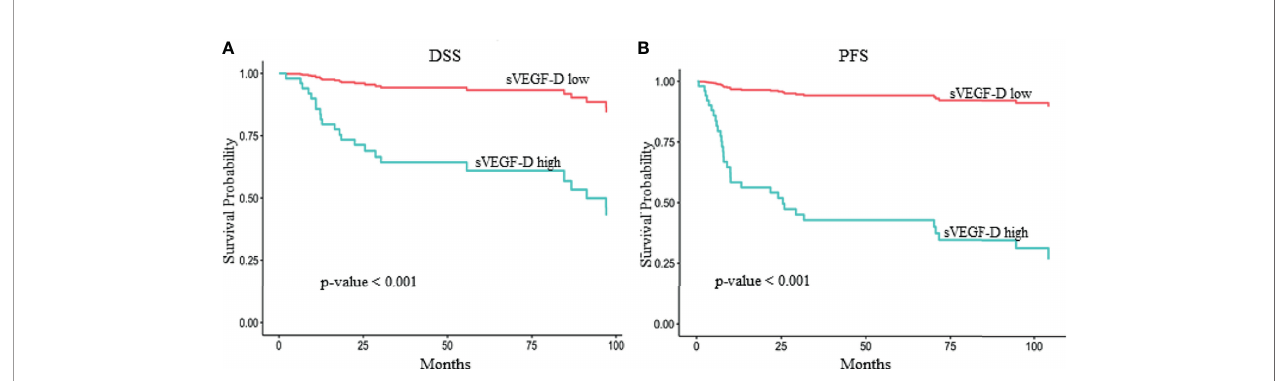
FIGURE 1 | Kaplan – Meier survival curves showing the effect of serum vascular endothelial growth factor D (sVEGF-D) level in multivariate models adjusted for stage, grade, and vascular and perineural invasion. The optimal threshold for sVEGF-D categorization was determined by maximally selected rank statistics. The reported p -values were adjusted for multiple testing. Higher sVEGF-D levels [>393 and >329 pg/ml for disease-speci fi c survival (DSS) and progression-free survival (PFS), respectively] exhibited a signi fi cant association with reduced DSS (A) ( p < 0.001) and PFS (B) ( p < 0.001) in 61 patients with vulvar squamous cell carcinoma (VSCC) from cohort